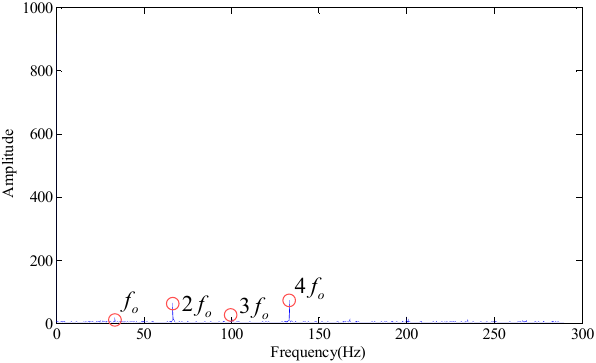
Figure 3. Envelope spectrum (singular values 5~8 are set to 0).